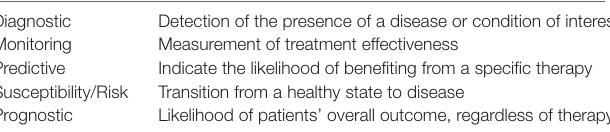
TABLE 1 | Categories of biomarkers and their